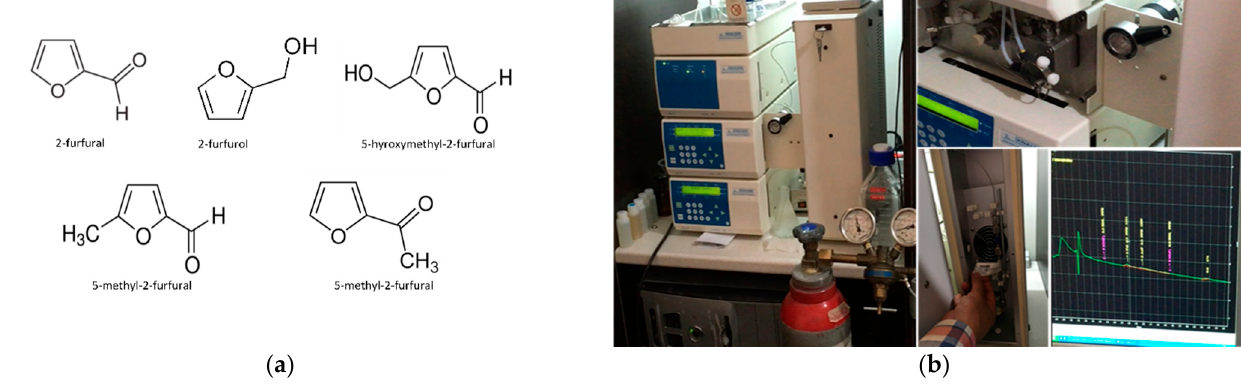
Figure 3. ( a ) Furan components in transformer oil; ( b ) HPLC test set-up for furan measurement of oil samples in this study.